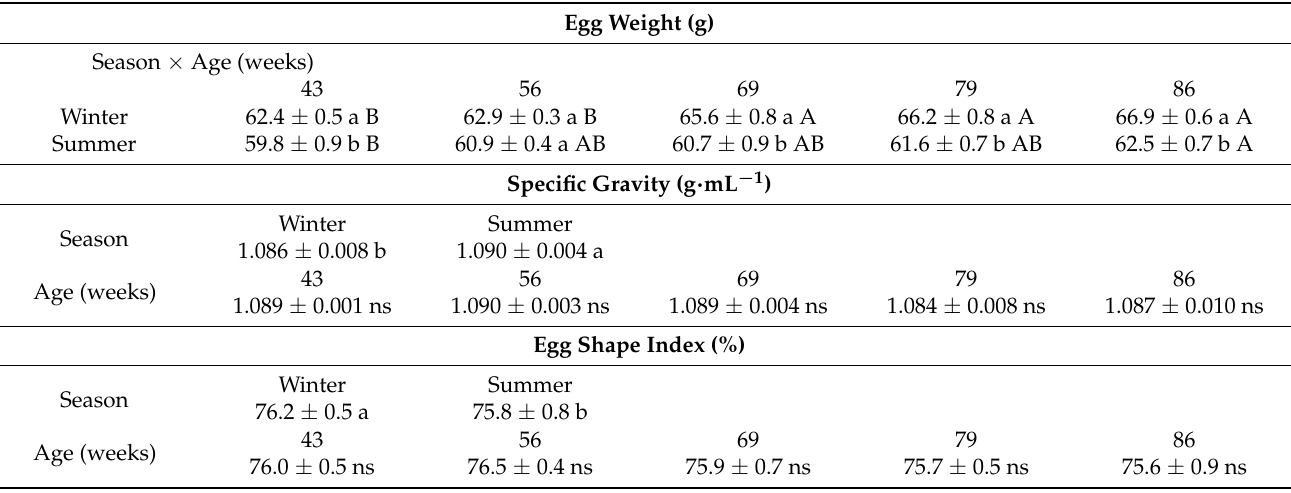
Table 4. Mean external egg quality measurements depend on the season of the year, the age of the hens, and their